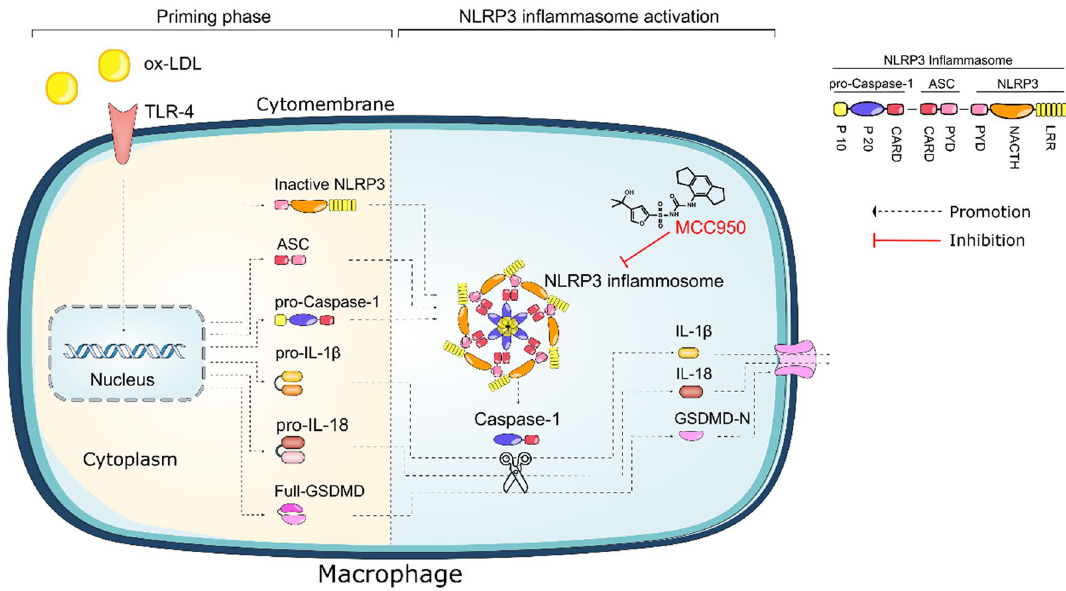
Figure 7. Ox-LDL can be recognized by pattern recognition receptor such as TLR-4, which in turn induce the upregulation of NLRP3, pro-caspase-1, GSDMD, pro-IL-1β, and pro-IL-18 (priming step) in macrophages. Then, NLRP3 would associate with ASC and pro-caspase-1 to form multi-protein complexes, which was referred as NLRP3 inflammasome (priming step). MCC950 inhibits NLRP3 activation and blocks ASC oligomerization and pro-Caspase1 cleavage into active Caspase-1 (activation step). As a result, Caspase-1 dependent pyroptosis and the formation of IL-1β, IL-18 and GSDMD-N in ox-LDL induced THP-1 macrophages are